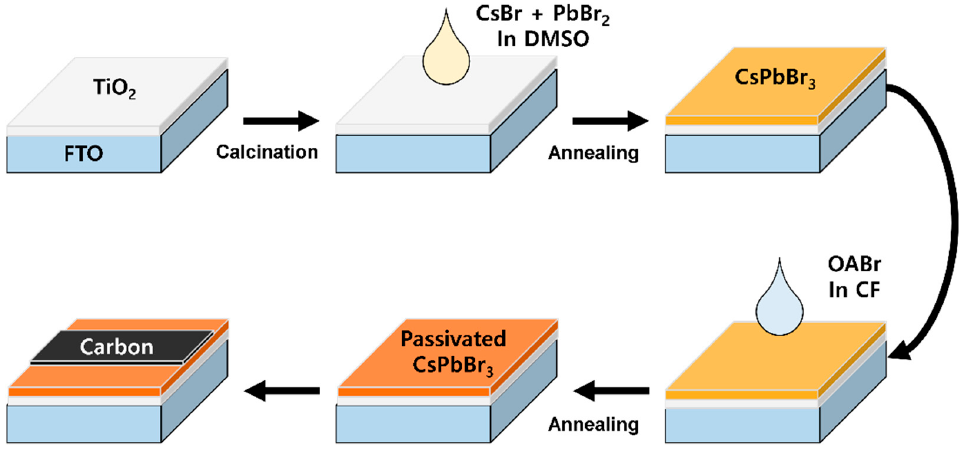
Figure 1. Schematic illustration of CsPbBr 3 PPVs.